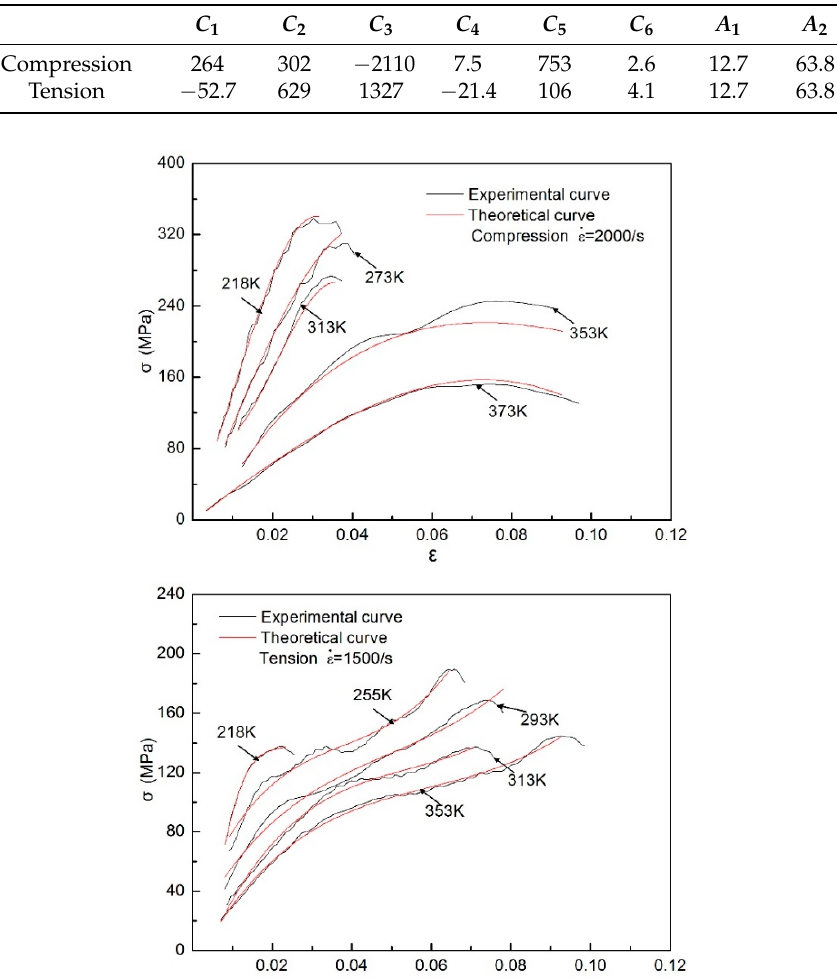
Figure 17. Comparison of experimental results and theoretical predictions of directional polymethylmethacrylate at various temperatures.